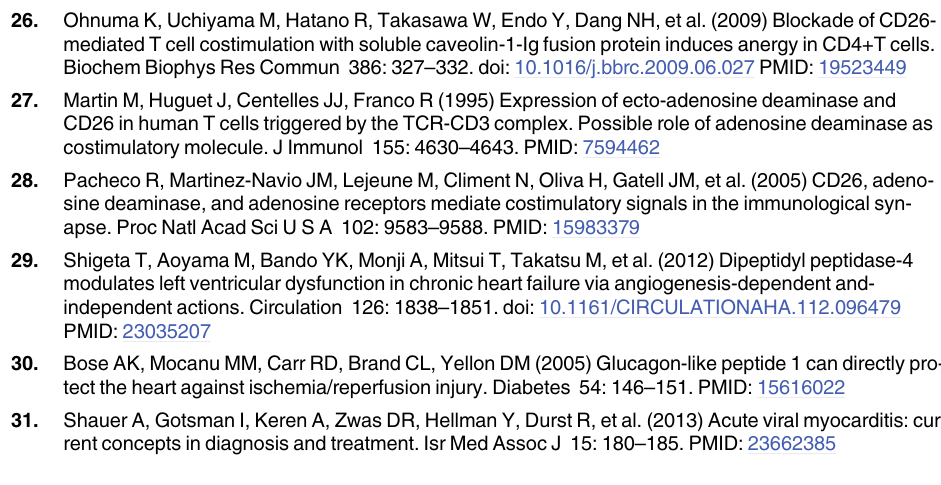
PLOS ONE | DOI:10.1371/journal.pone.0119360 March 13,